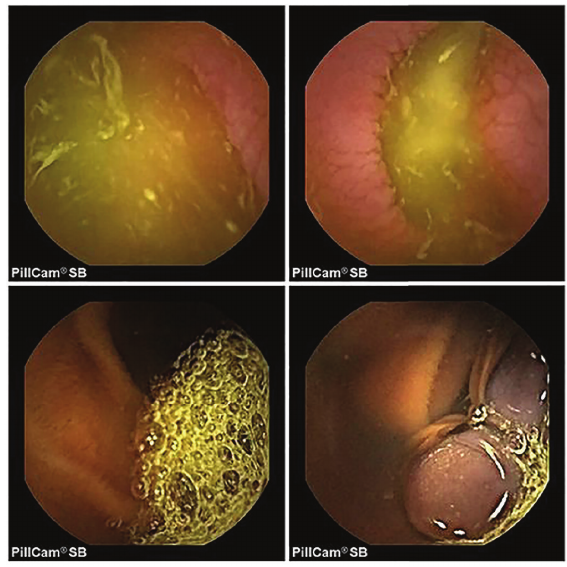
Figure 7: Several normal WCE images.